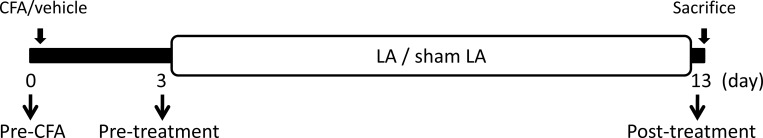
Experimental design.Complete Freund’s adjuvant (CFA) or vehicle was intraarticularly injected at Day 0. Pain withdrawal threshold and swelling assessments were examined at timepoints of Pre-CFA, Pre-treatment and Post-treatment. Three days after injection of CFA (Day 3), animals were treated with laser acupuncture (LA) and sham-operated LA (sLA). Following the 10-day treatment (Day 13), animals were sacrificed for histology and immunohistochemistry assays.